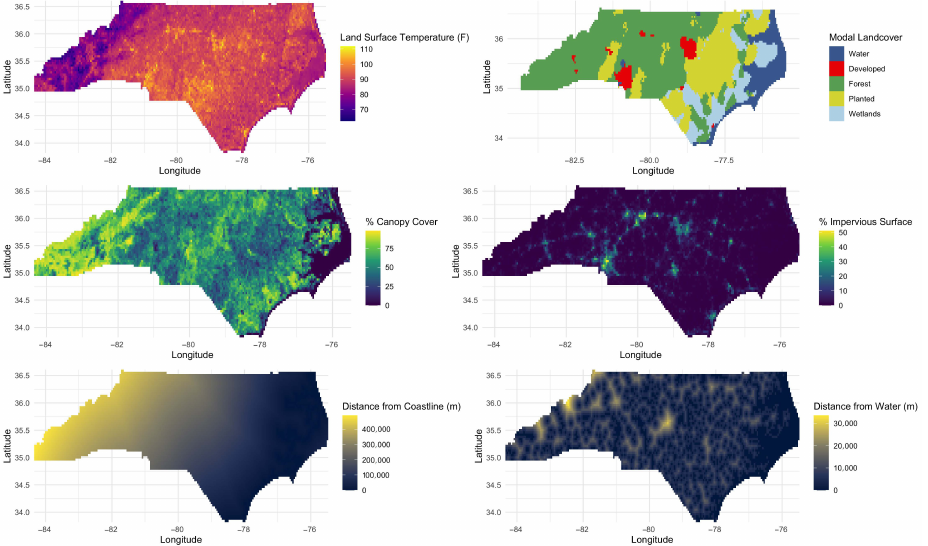
Figure 2. Covariates for the model shown on the GridMET grid.